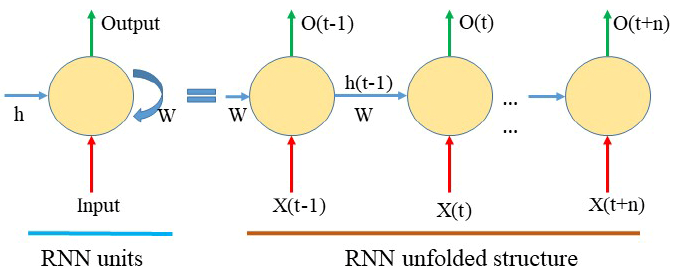
Figure 4. Schematic diagram of the classical recurrent neural network (RNN) structure.